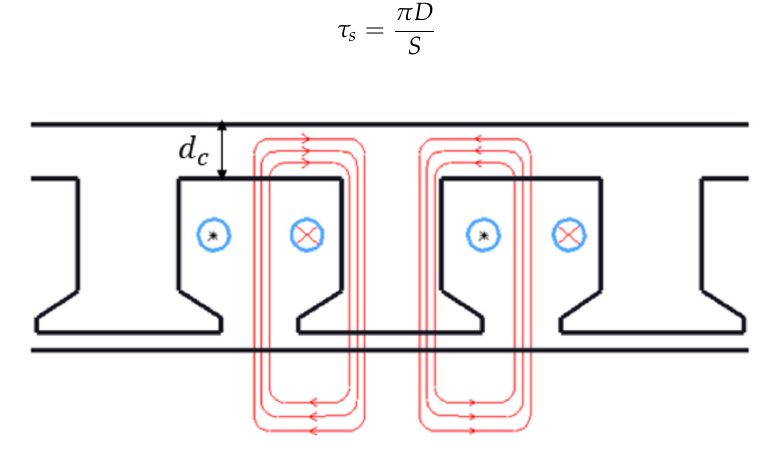
Figure 3. Flux density curve and flux of one pole